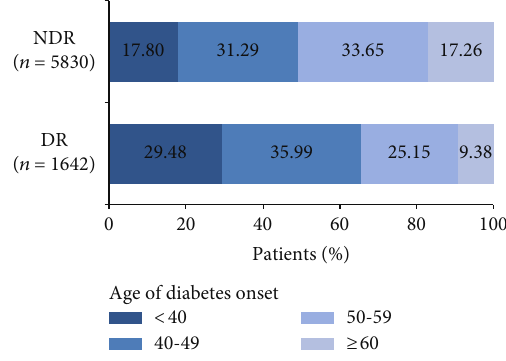
Figure 2: Distribution of the age of diabetes onset in patients with diabetic retinopathy (DR) and without diabetic retinopathy